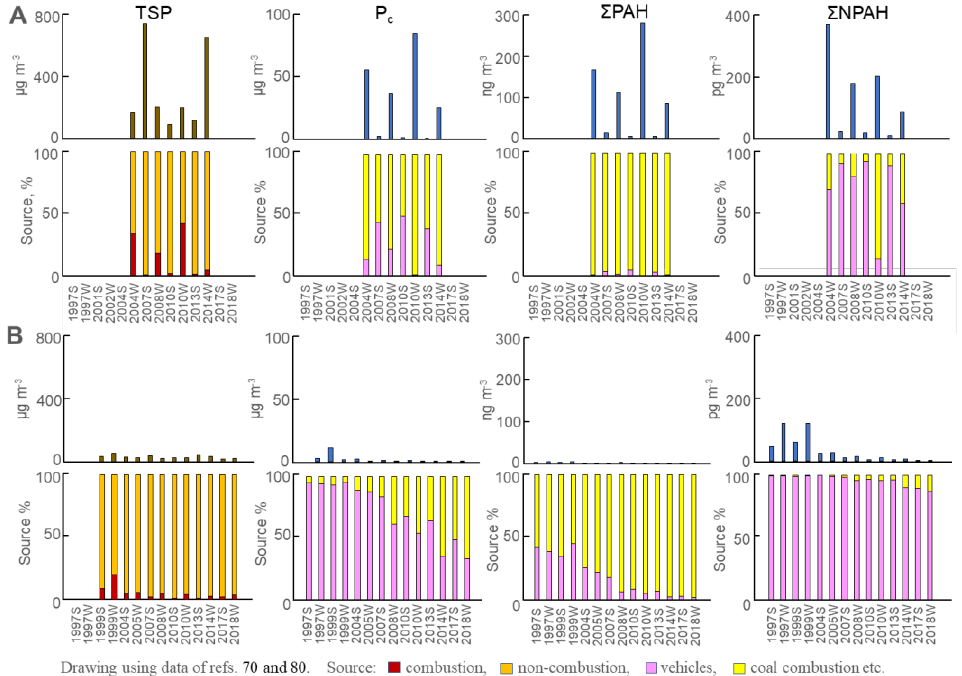
Figure 2. Atmospheric Concentrations of TSP, P c , Σ PAH and Σ NPAH, and Source Contributions to them in ( A ) Beijing, China and ( B ) Kanazawa, Japan. The NP method calculation used data from refs 74 and 75.